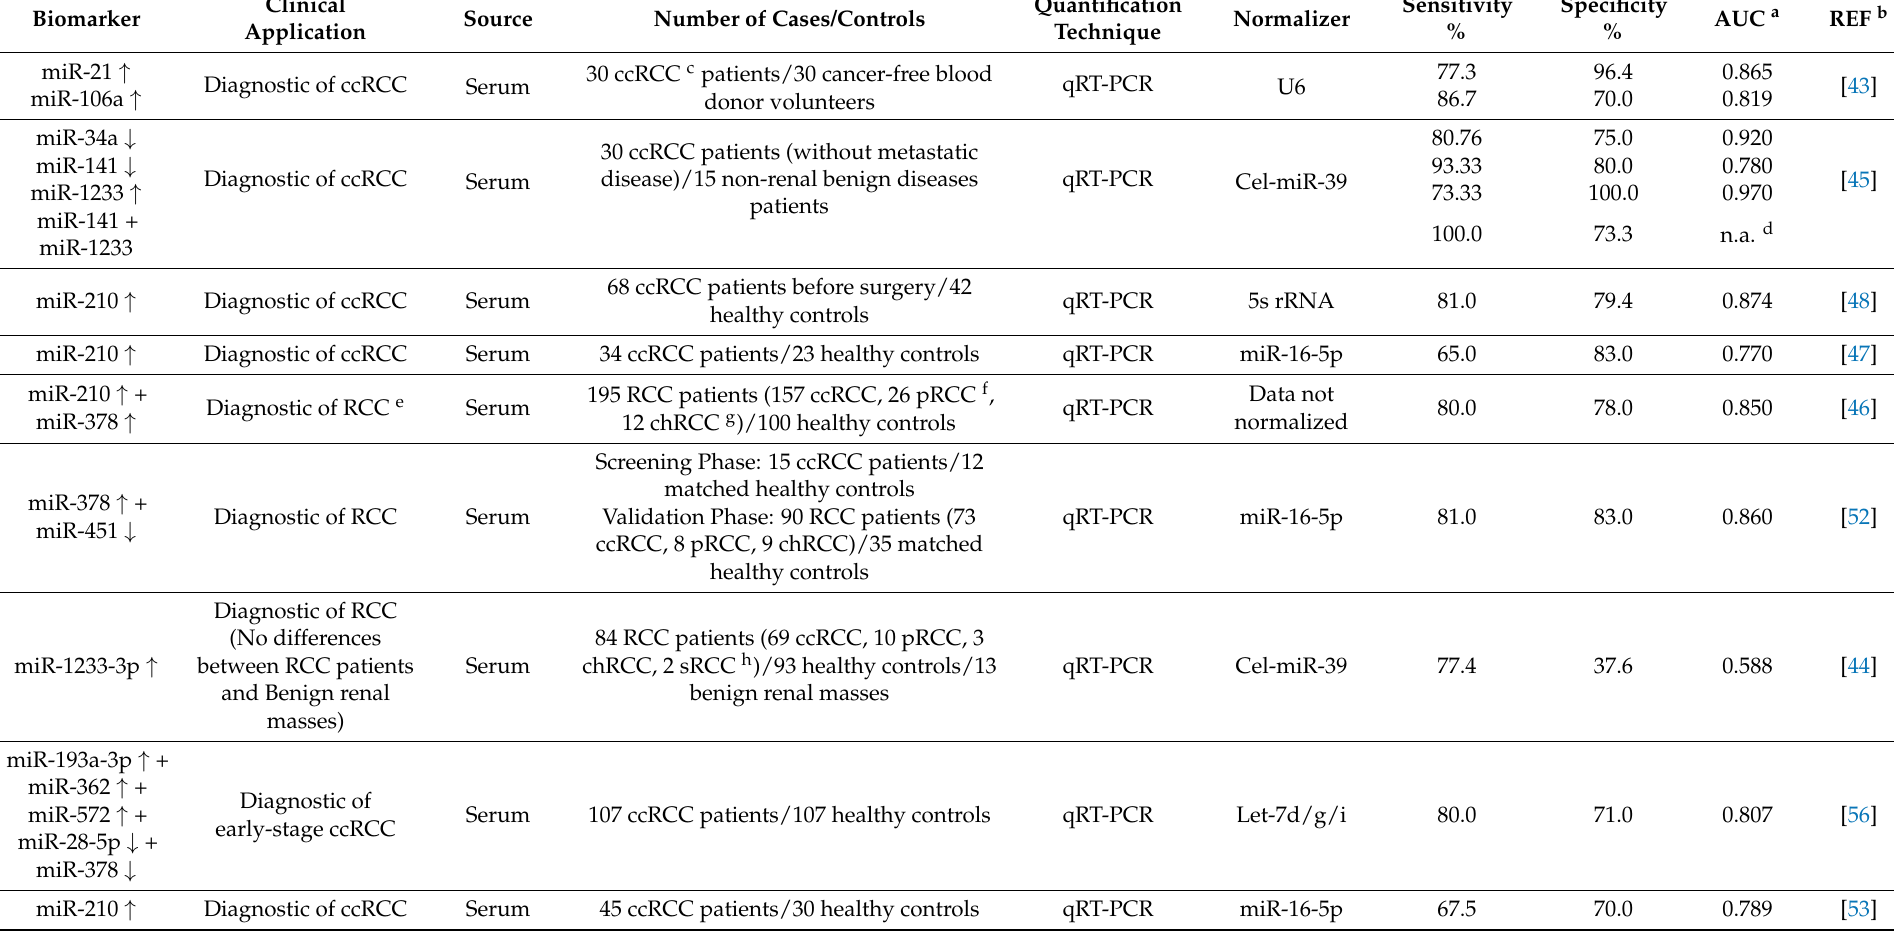
Table 1. Promising diagnostic circulating miRNA in renal cell carcinoma